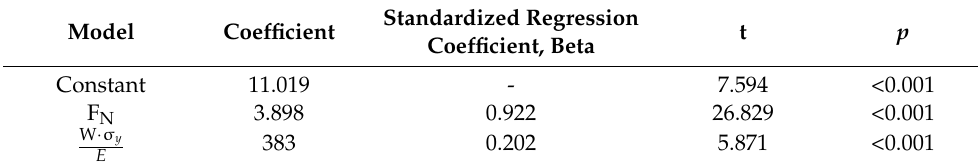
Figure 6. Specific wear rate of the tested materials (FM, TM, MP) in the function of tip radius ( µ m) and indenter cone angle ( γ ) for different loads ( a ) F N 0.9 N, ( b ) F N 10.8 N. Table 4. Coefficients of the regression model for scratch width in single-asperity test.